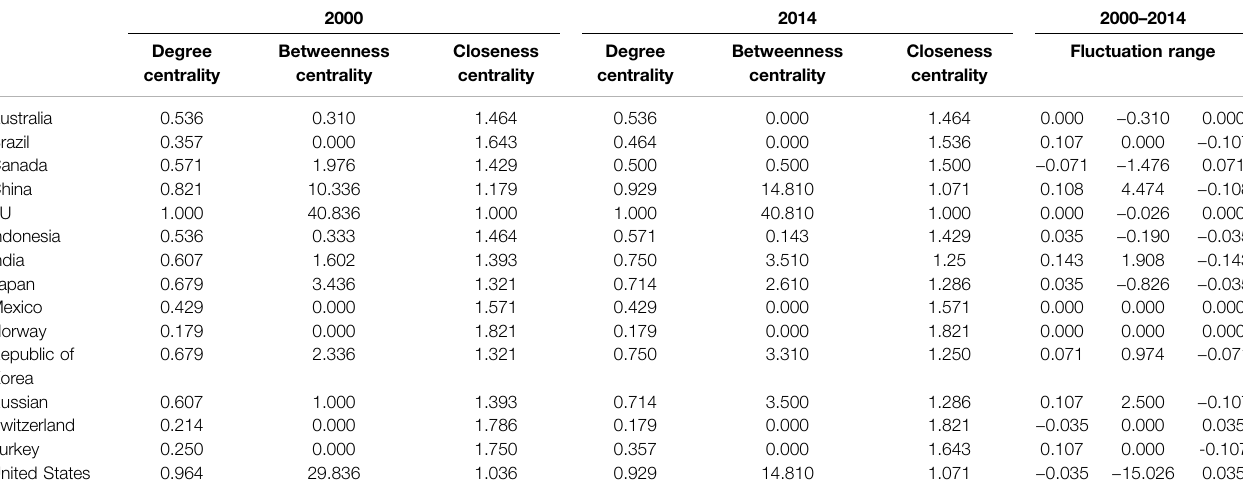
TABLE 3 | Centrality indicators and changes of major economies from 2000 to